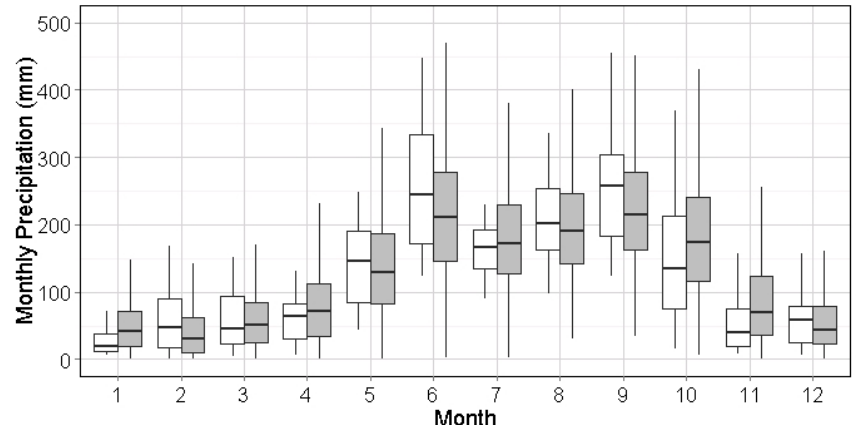
Figure 13. Comparison of monthly precipitation of synthetic series and historical observations in Syracuse (Historic: White, Synthetic: Grey).